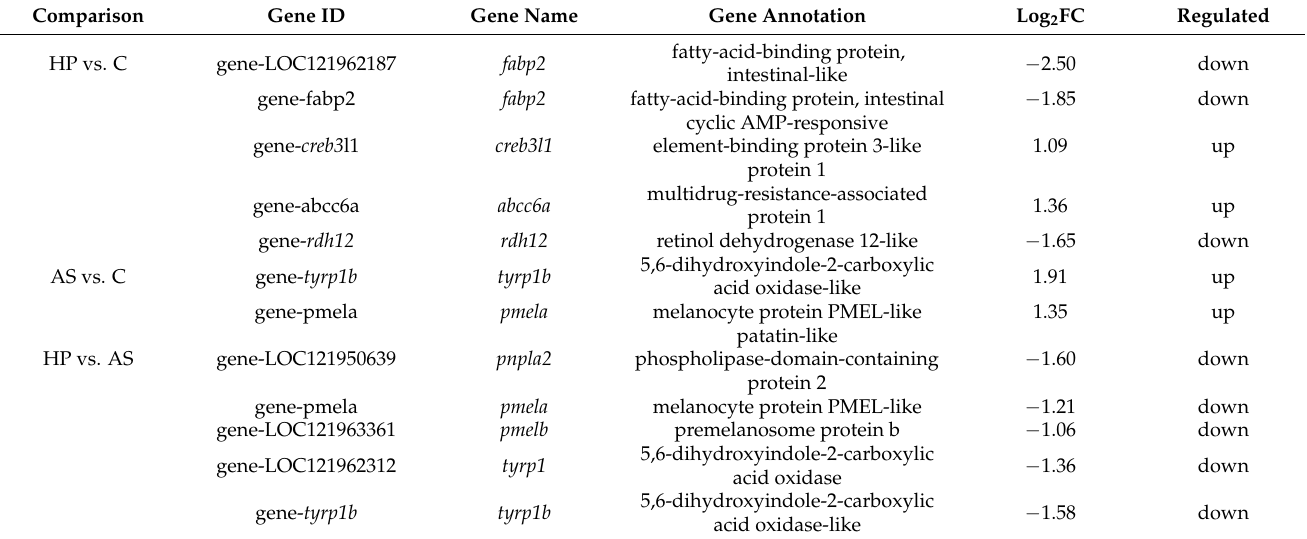
Table 3. Differentially expressed genes associated with body